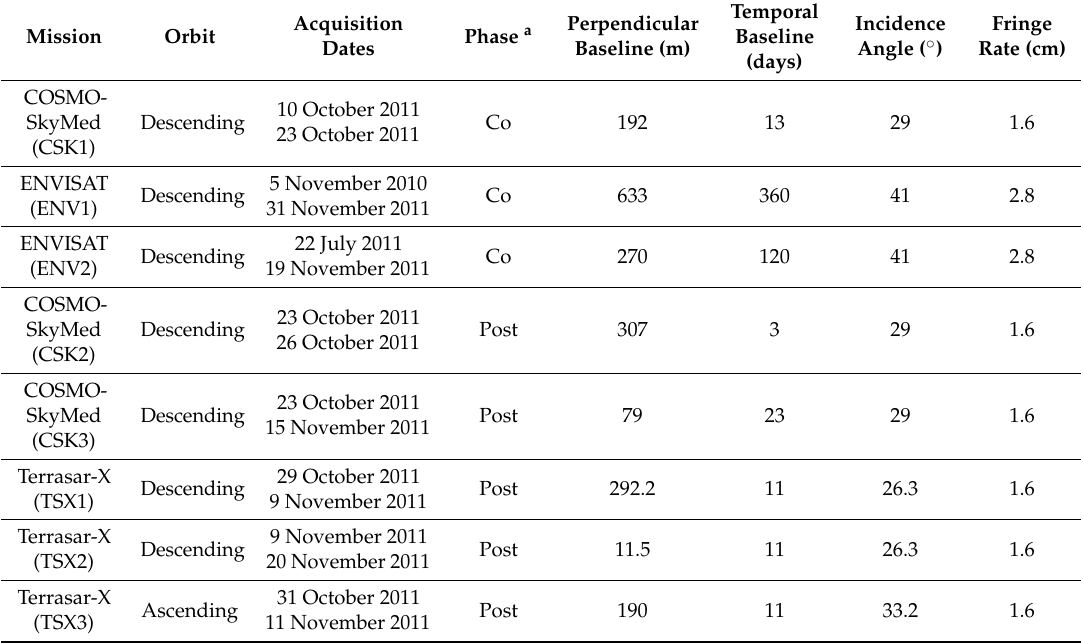
Perpendicular Acquisition Phase a Baseline (m) Dates